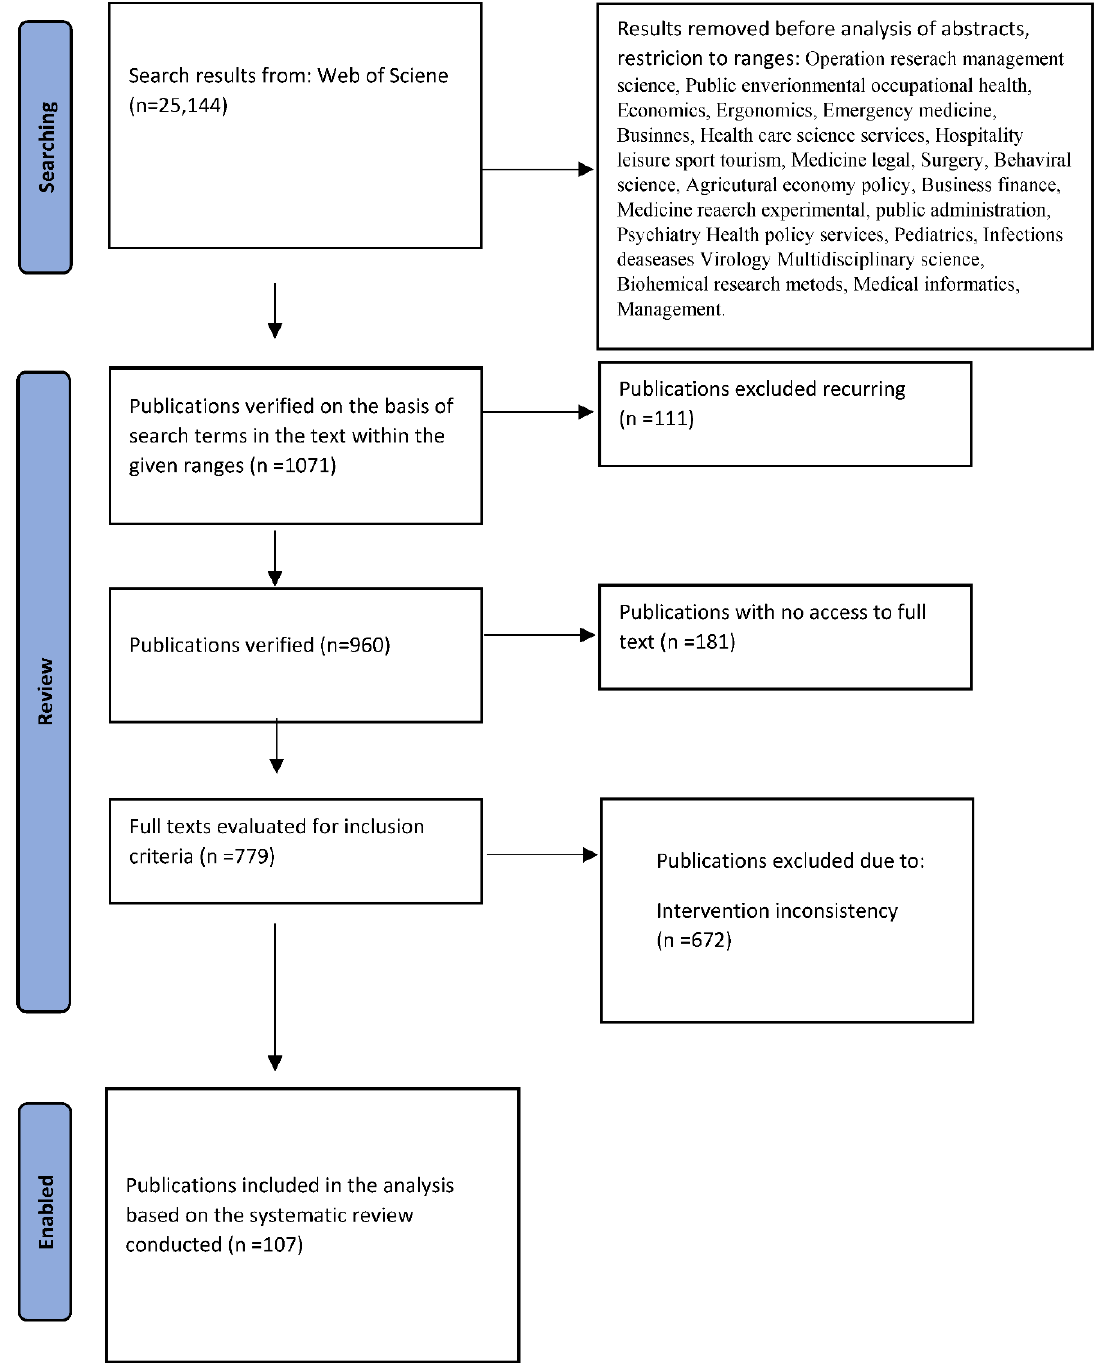
Figure 1. Literature analysis.